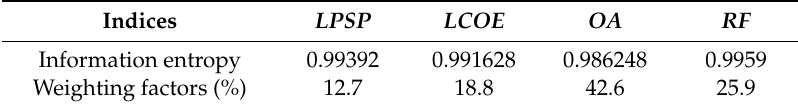
Table 5. Information entropy and weighting factors of each